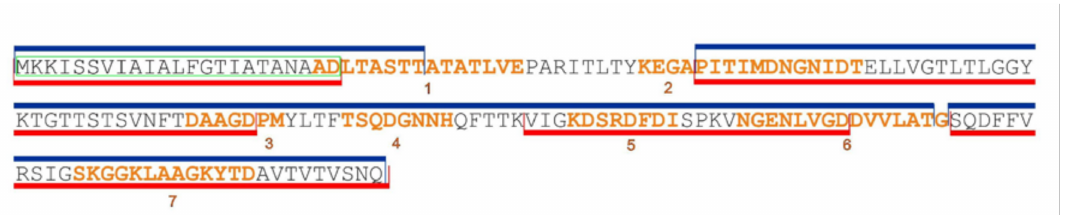
Figure 4. In silico identification of seven linear epitopes predicted by ElliPro (http: // tools.iedb.org / ellipro / ) [23]. The epitopes are numbered sequentially from 1–7 through the F1 protein and colored in orange. The fragments of F1 positive in ELISA with peptide library tested with sera from the vaccines of the groups A-RV and A-EV are colored in blue and red, respectively. The green box indicates a signal peptide on F1 full-length